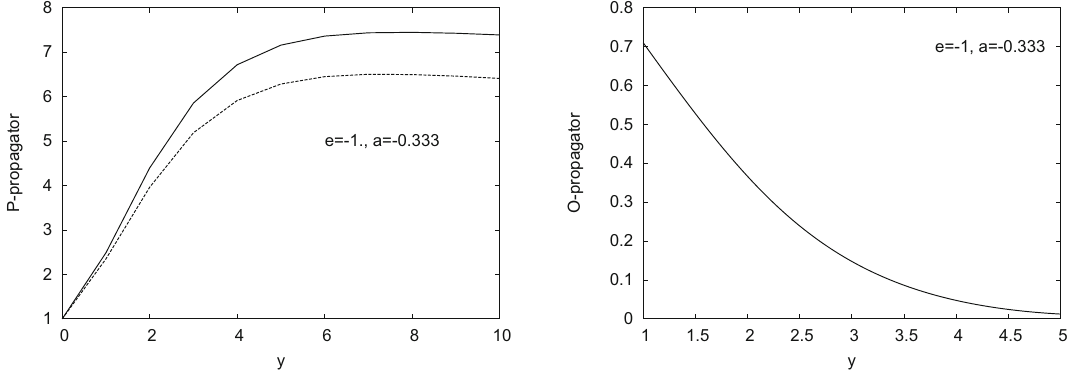
Fig. 8 The solid curves show pomeron (left panel) and odderon (right panel) propagators as functions of rapidity for μ = 1, λ = 1 / 3. The dashed curve in the left panel shows the pomeron propagator in absence of the odderon (only pomeron loops)